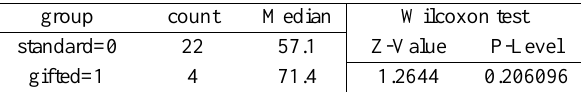
Table 5 Distribution of standard and gifted students and results